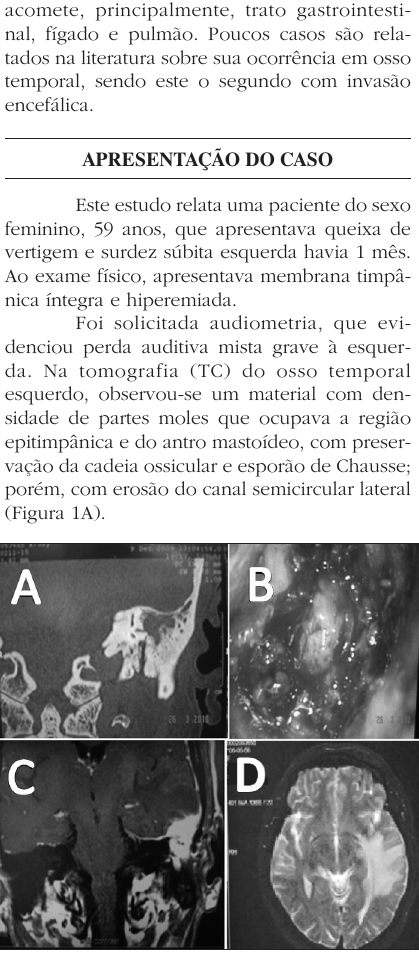
Figura 1. A: Tomografia computadorizada de ossos temporais evidenciando lesão que erodia o canal semicircular lateral; B: Aspecto do tumor no intraoperatório; C: Ressonância magnética (RM) de crânio T1 pós-contraste mostrando a invasão do tumor no lobo temporal esquerdo; D: RM de crânio em T2, na qual observa-se grande edema